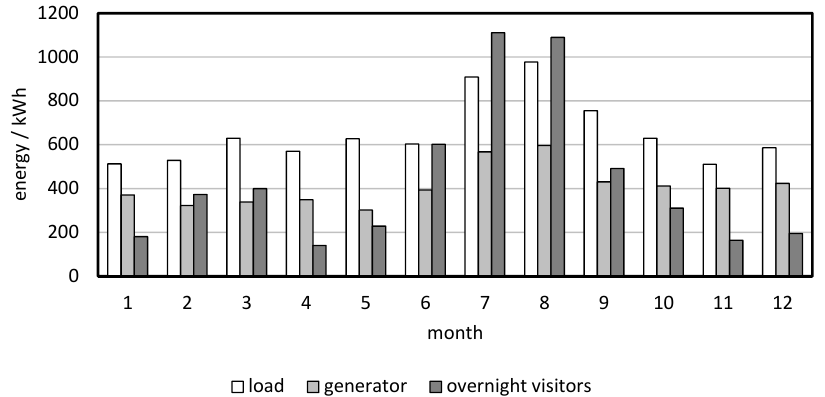
Figure 2. Monthly energy consumption and production with diesel generator.